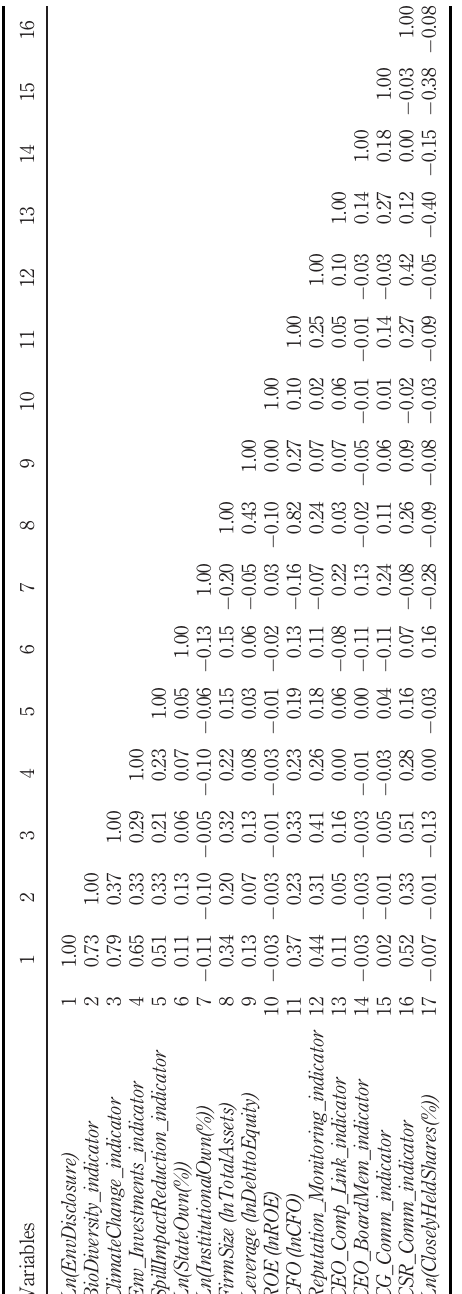
Table 4. Correlation